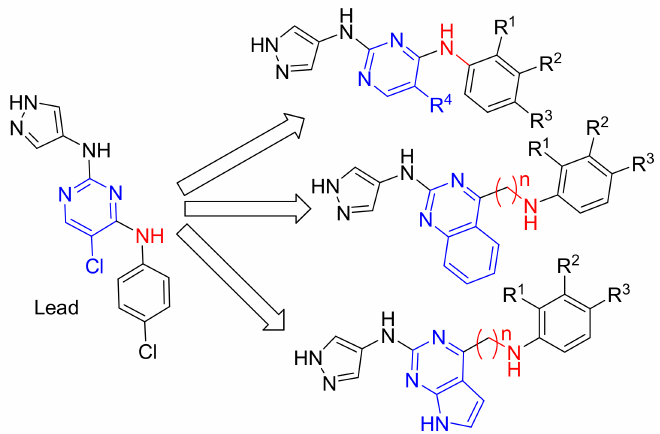
Figure 44. Schematic view of general designed compounds synthesized and